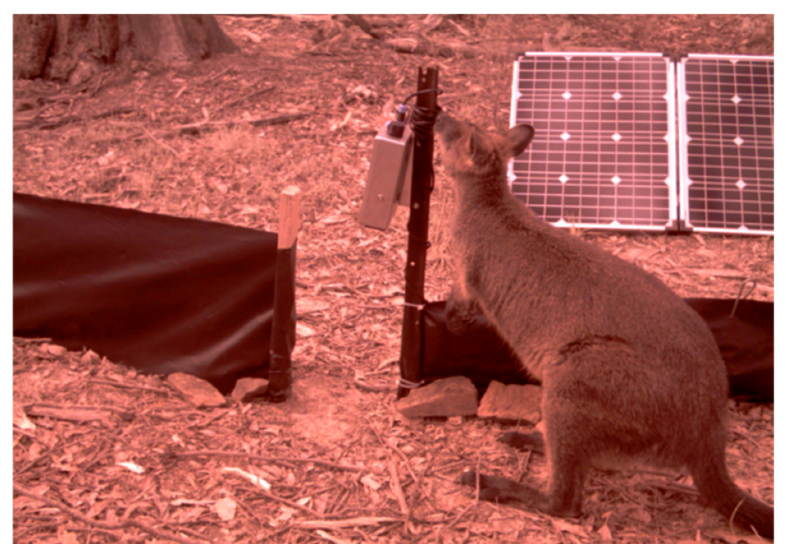
Figure 7. Camera trap setup mounted to stake with artificial passage, directing animals into the camera’s field of view of the ground, and solar panel powering the setup.